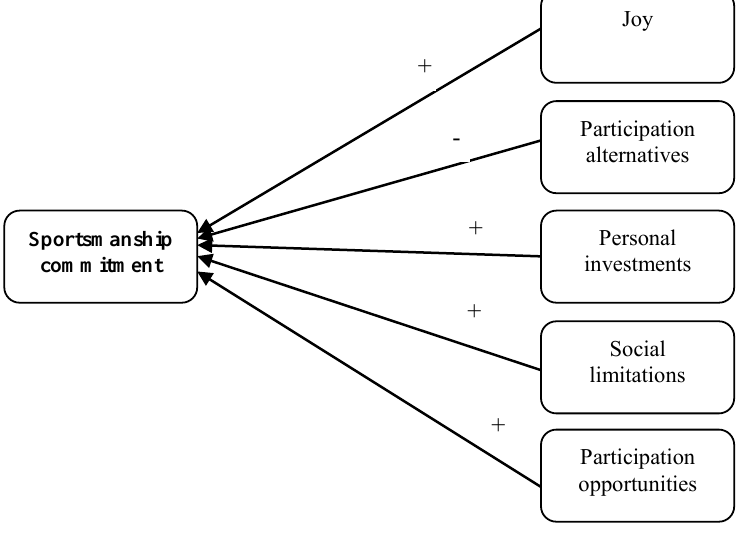
Figure 2. Sports manship commitment model